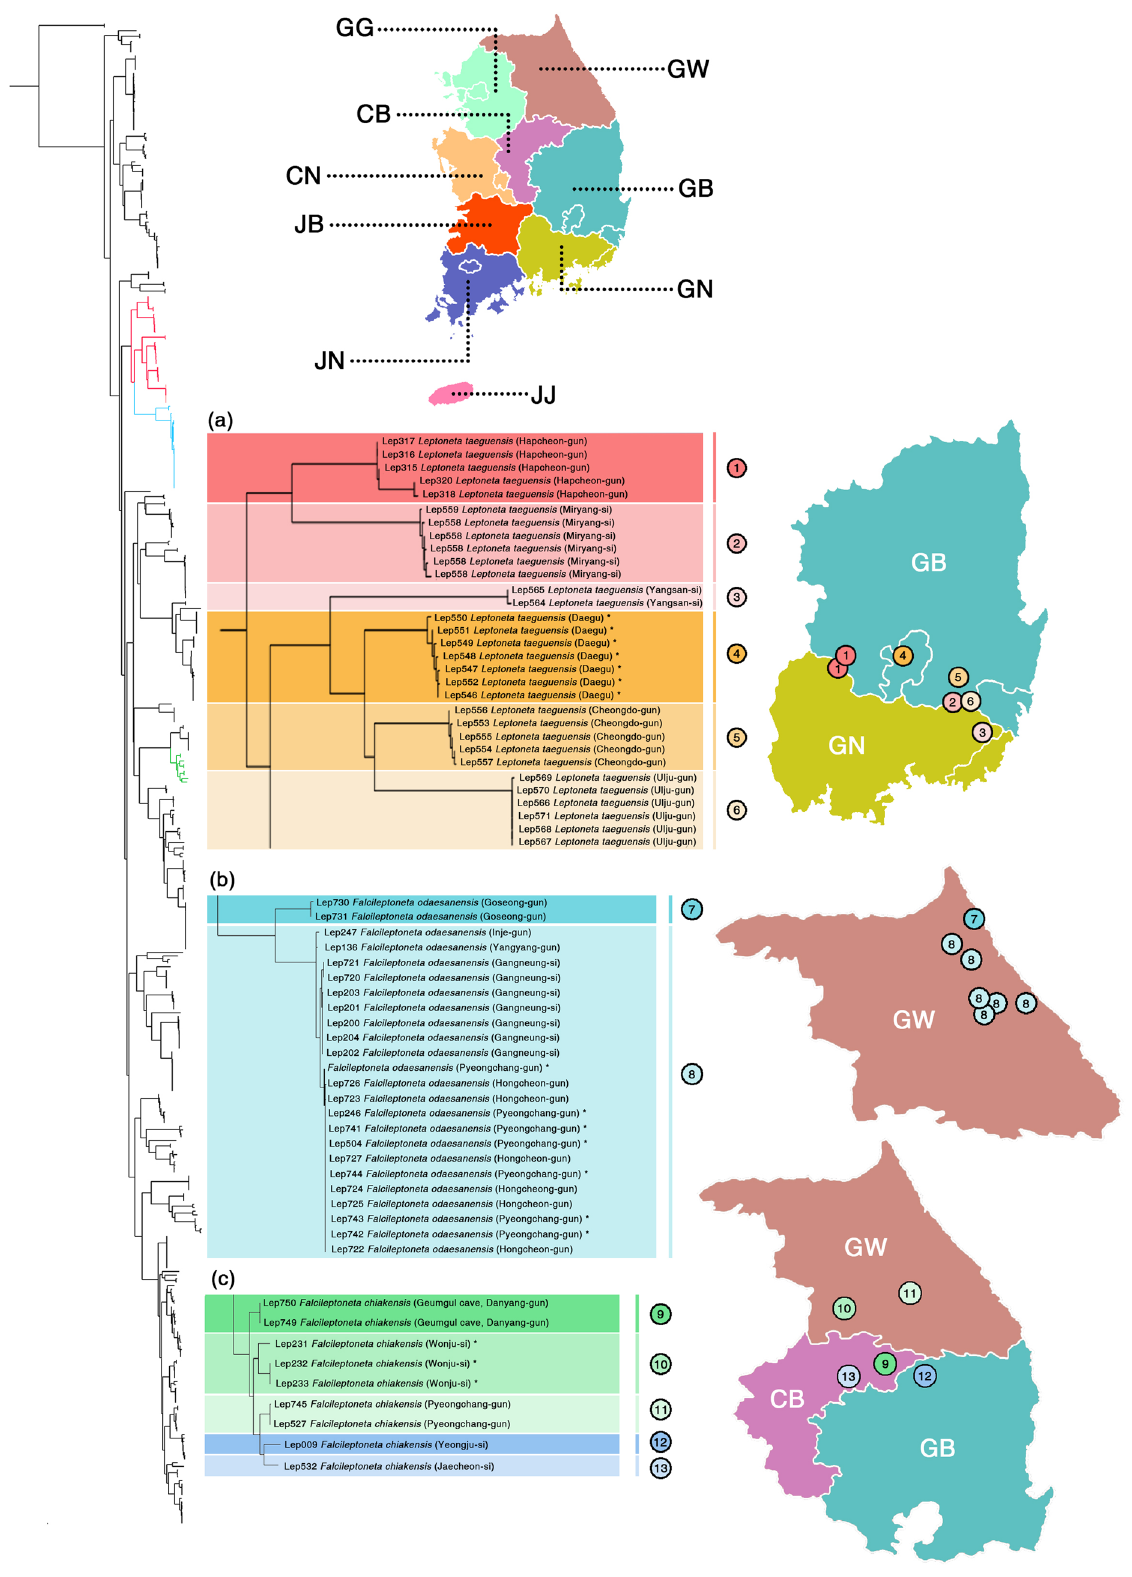
Figure 4. Cryptic species between various populations of epigean leptonetids with a map of sampled localities. All maps were prepared using QGIS 3.22.1 (https:// www. qgis. org/ ko/ site/). ( a ) Leptoneta taeguensis from (1) Hapcheon- gun, (2) Miryang-si, (3) Yangsan-si, (4) Daegu, (5) Cheongdo-gun, and (6) Ulju-gun; ( b) Falcileptoneta odaesanensis from (7) Goseong-gun, (8) Inje-gun, Yangyang-gun, Gangneung-si, Pyeongchang gun, and Hongcheon-gun, ( c ) Falcileptoneta chiakensis from (9) Danyang-gun, (10) Wonju-si, (11) Pyeongchang-gun, (12) Yeongju-si, and (13) Jaecheon-si. Asterisks represent the individuals collected from type